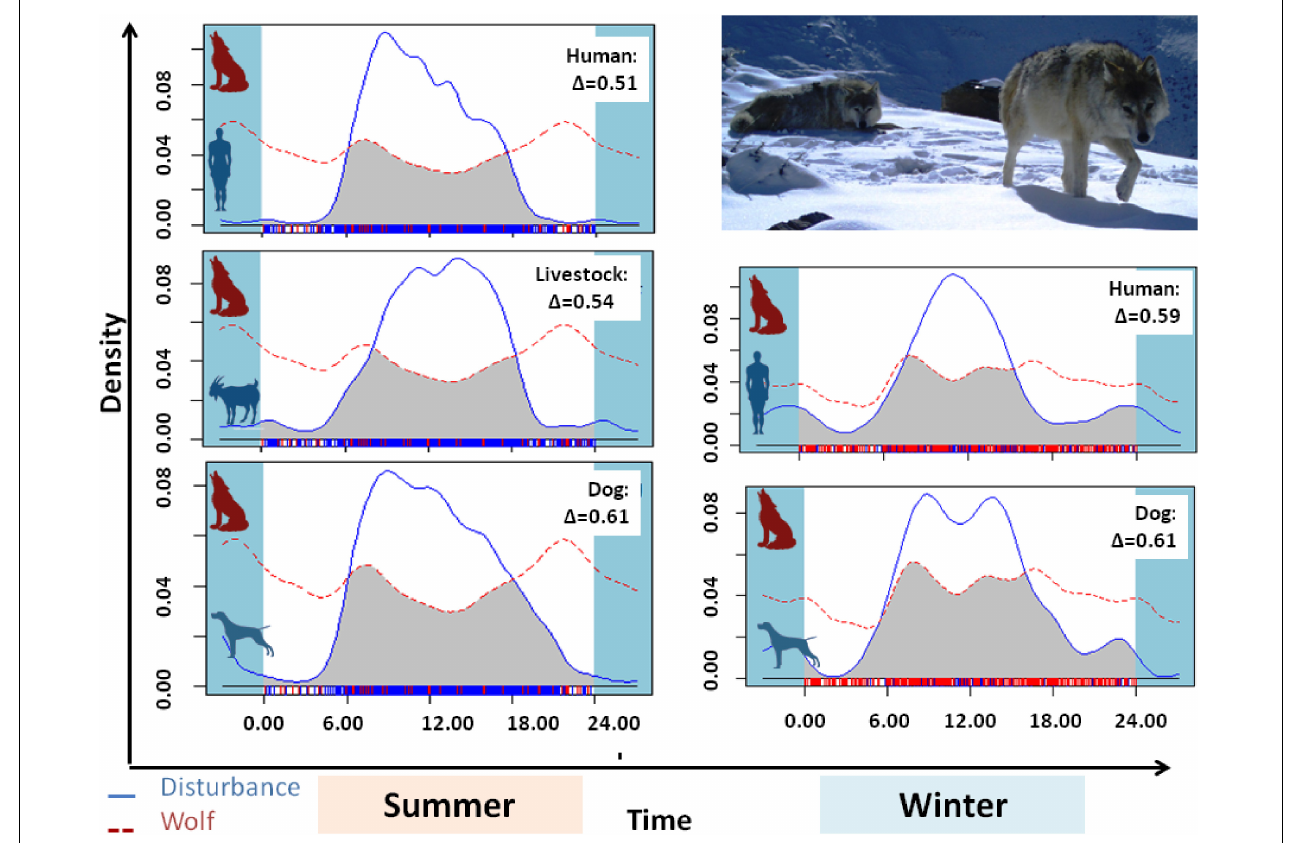
FIGURE 3 | The activity overlap (gray area) and overlap coefficient ( (cid:49) ) of anthropogenic disturbance (people, livestock, and domestic dogs) with woolly wolves in the summer and winter seasons in the Nelang valley of the Gangotri National Park, Uttarakhand, India. Original observations are displayed as a rug at the bottom of the